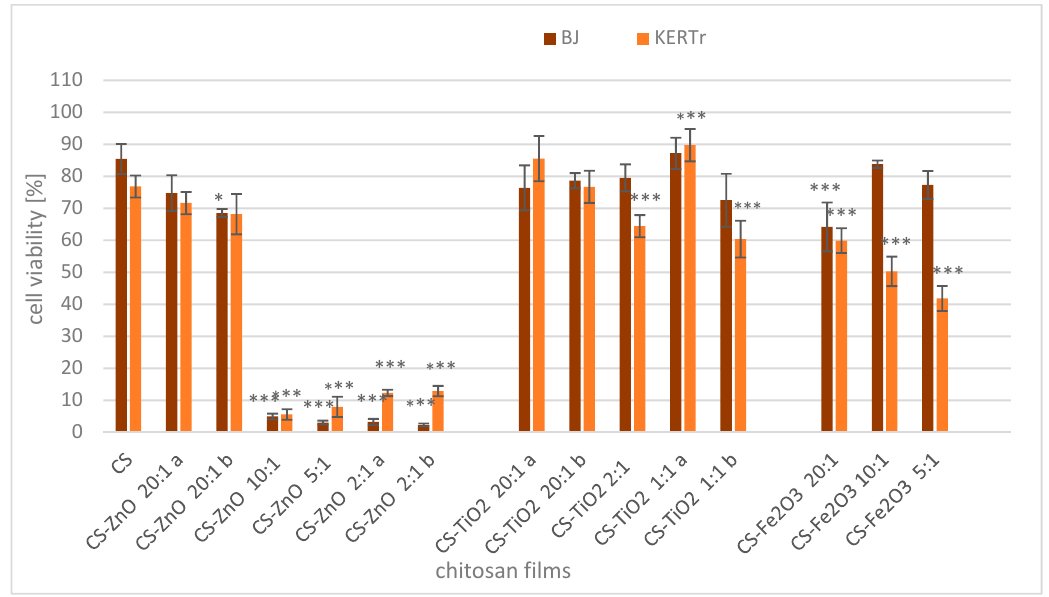
Figure 7. Viability of human fibroblast (BJ) and keratinocyte (KERTr) cells after 24 h of exposure to chitosan and chitosan − metal oxide composites. Cell viability was calculated as the percent ratio of absorbance of the samples to the referent control (untreated cells). The value from control group was set as 100%. Statistical significance is marked in relation to the chitosan nanocomposite (CS) ( n = 6, * p < 0.05, *** p < 0.001).